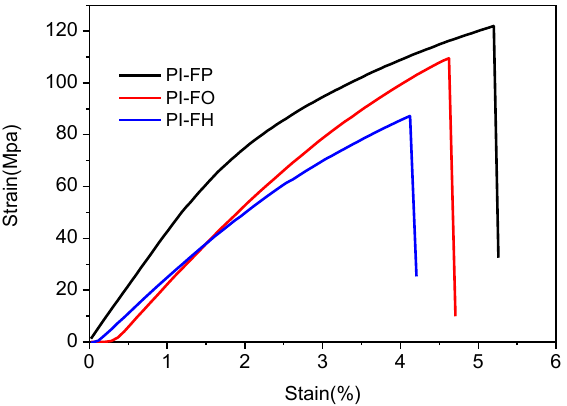
Figure 9. Measured stress versus strain curves of PI films subjected to tensile tests. Table 5. The tensile strength, tensile modulus, and elongation at break of PI films. Films